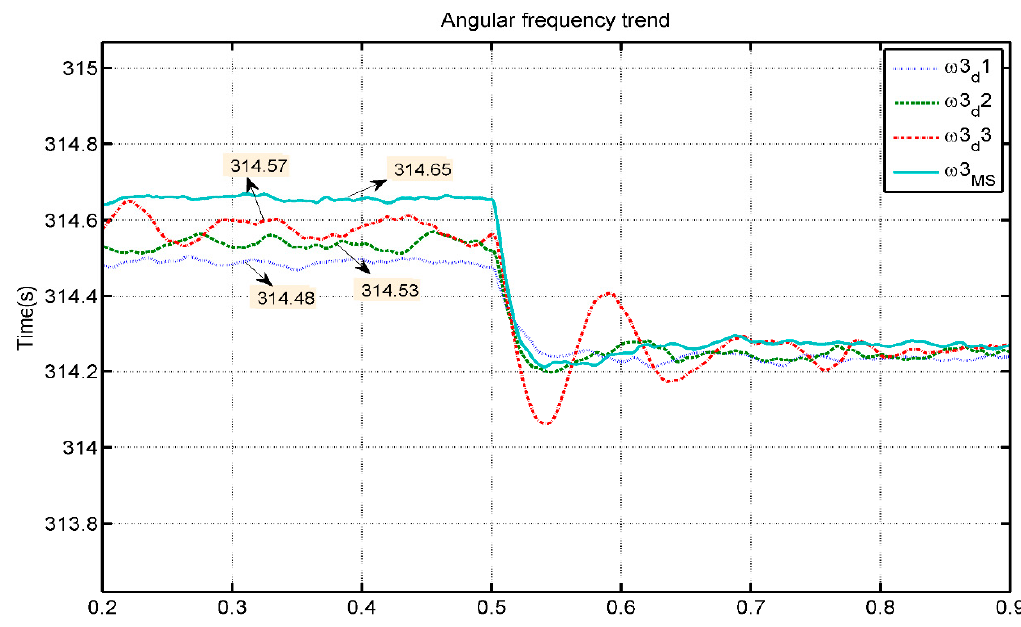
Figure 16. Comparison of angular frequency (VSG-3).